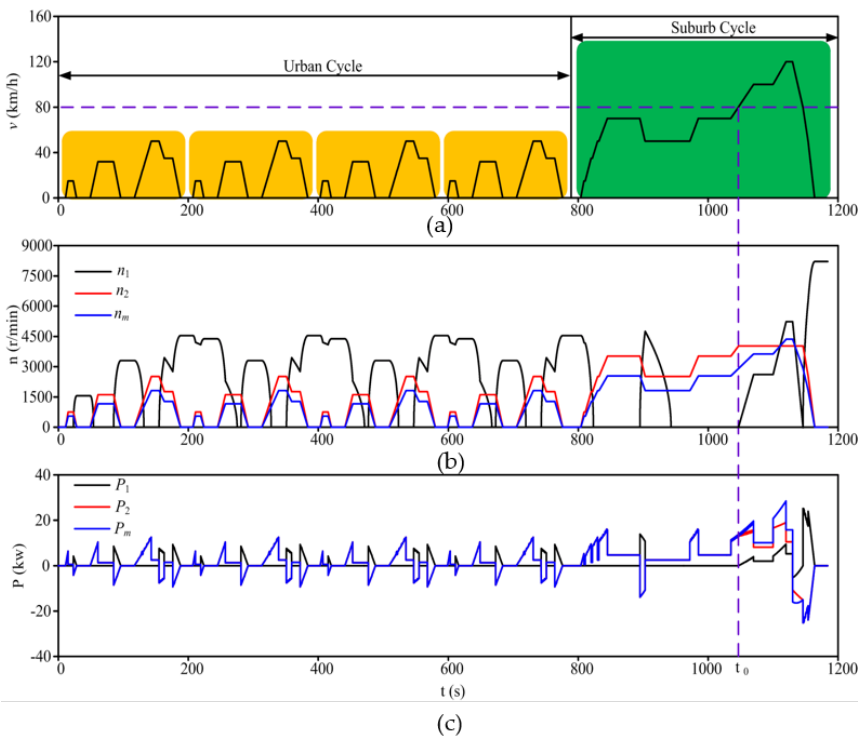
Figure 10. ( a ) New European Driving Cycle (NEDC); ( b ) Rotational speeds; ( c ) Powers (From top to